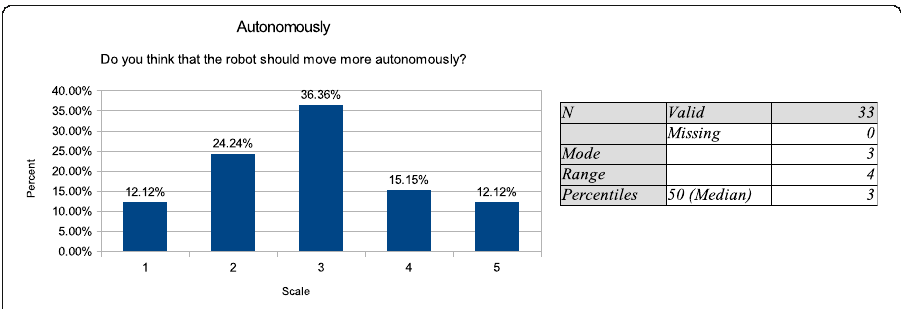
Fig. 8 The Likert-scale graph and table of the question